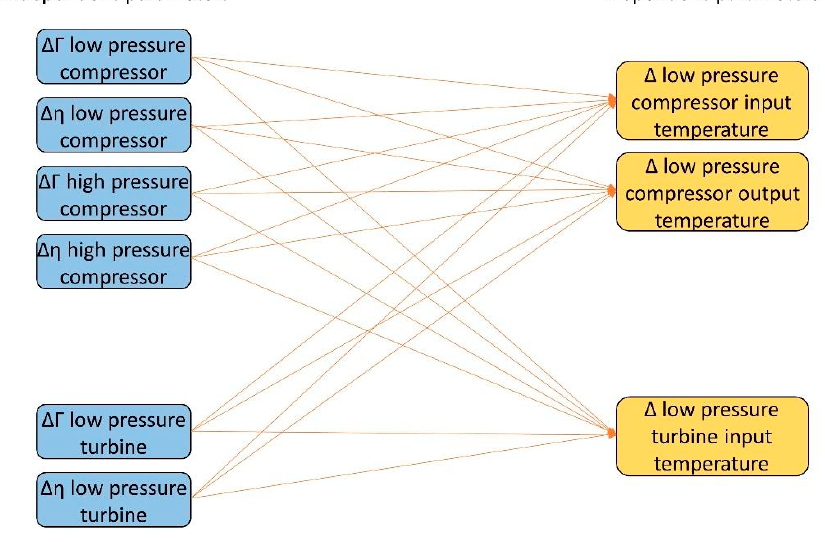
Figure 15 . Typical BBN structure for GT diagnostic purposes. Adapted from [39]. Figure 15. Typical BBN structure for GT diagnostic purposes. Adapted from